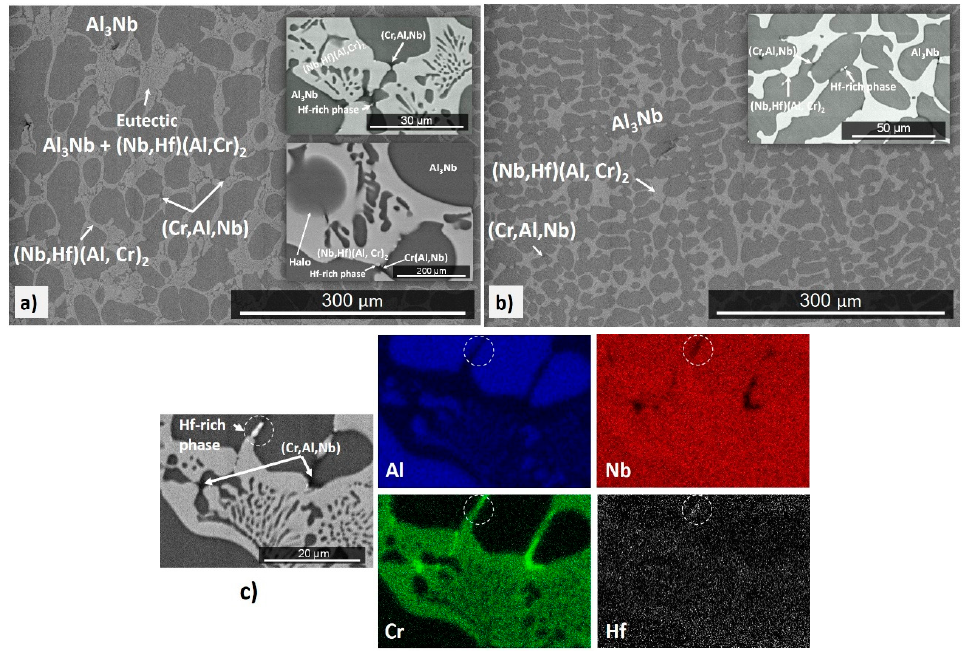
Figure 1. Back scatter electron (BSE) images ( a ) and ( b ), and ( c ) X-ray maps of the microstructure of the alloy OHC3-AC, ( a ) bulk, X190, ( b ) bottom, X200, ( c ) BSE image (X2000). In ( c ) the encircled areas correspond to the Hf-rich particle.